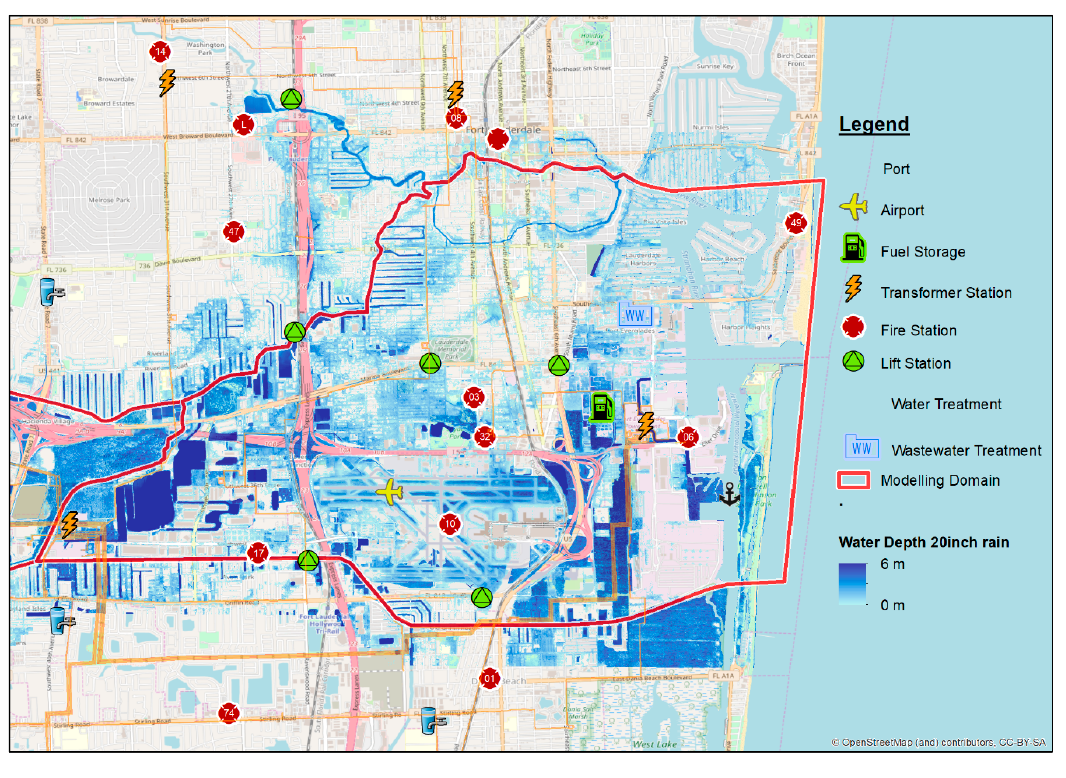
Figure 6. Flood depth map corresponding with the event.